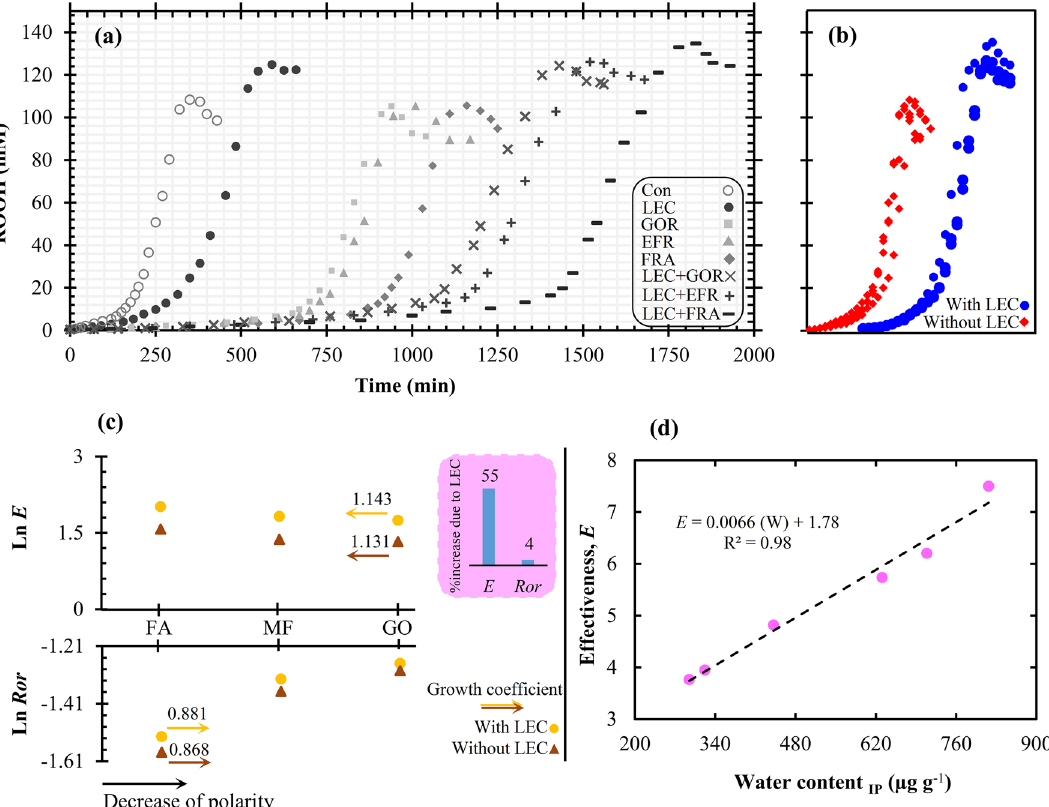
Figure 2. ( a ) Sigmoidal curve of hydroperoxides (ROOHs) accumulation in the peroxidation of stripped sunflower oil (Control) containing lecithin (LEC), ferulic acid (FRA), ethyl ferulate (EFR), γ-oryzanol (GOR) and their combinations at 60 °C, ( b ) comparison of graphs of ROOHs production in the presence or absence of lecithin, ( c ) displaying variations in the kinetic parameters of effectiveness ( E ) and the ratio of oxidation rate ( R or ) of antioxidants in the presence and absence of lecithin, and ( d ) the relationship between the effectiveness parameter of antioxidants and water content at the IP